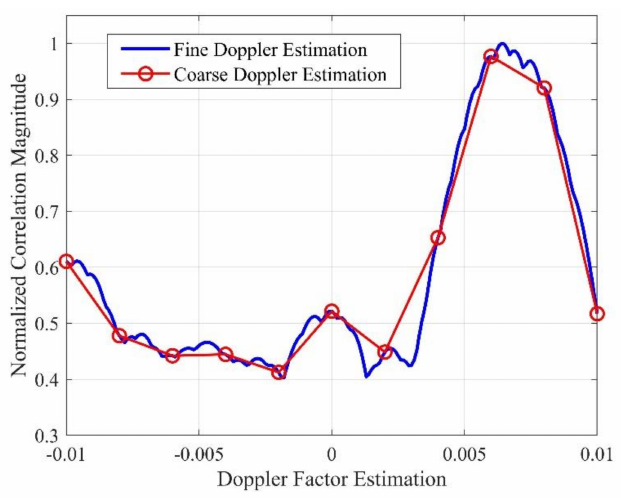
Figure 7. Single symbol Doppler estimated curves.